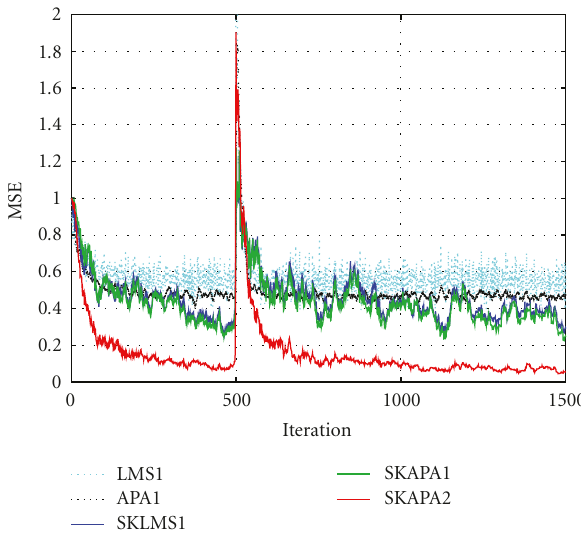
Figure 9: Ensemble learning curves in the nonlinear channel equalization with an abrupt change at iteration 5000.